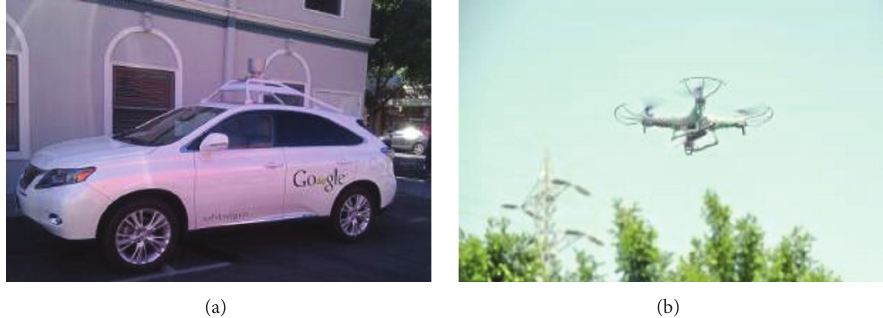
Figure 1: Photographs of (a) Google self-driving car (image source: Wikipedia Commons. Author: Mark Dolinar. Used under the Creative Commons Attribution-Share Alike 2.0 Generic license) and (b) autonomous UAV (image source: Wikipedia Commons. Author: Miki Yoshihito. Used under the Creative Commons Attribution-Share Alike 2.0 Generic